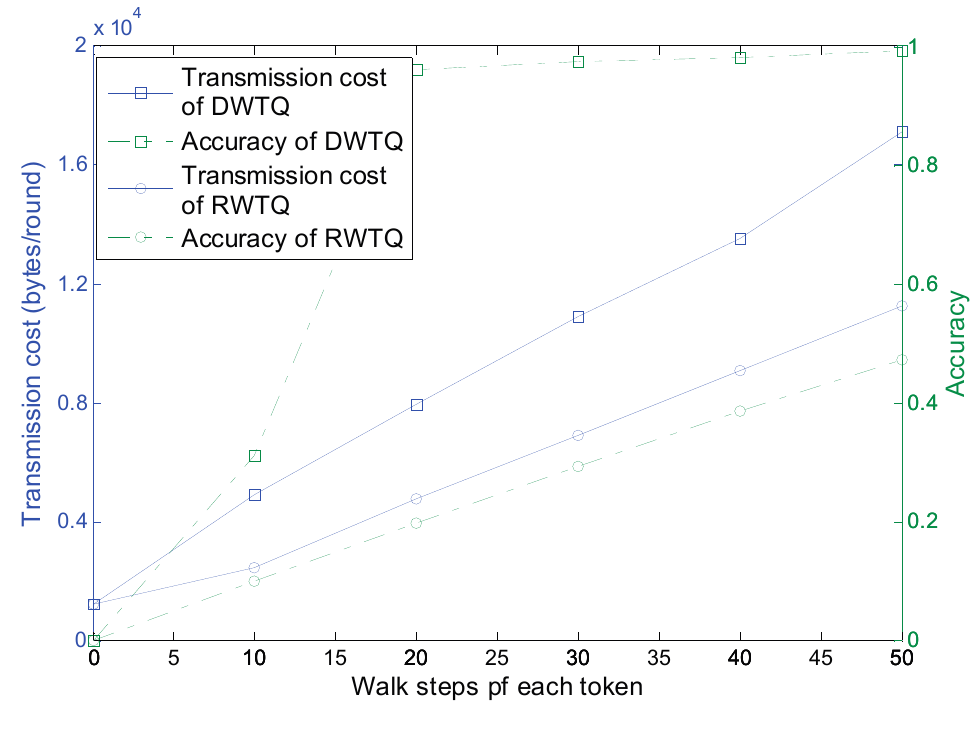
Figure 15. Transmission cost and query